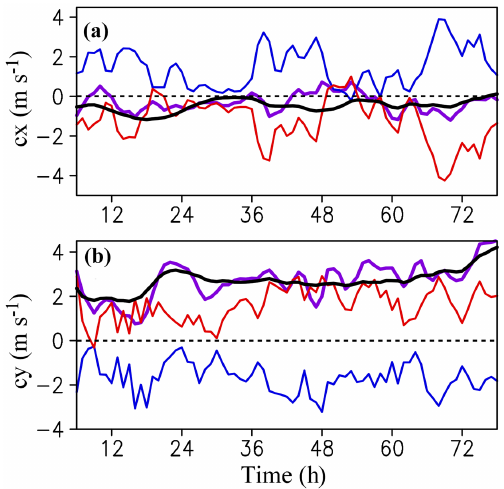
Figure 8. Time series of the conventional steering (thick black) and the contributions of the HA (thick purple), HA1 (red) and HA2 (blue) terms: (a) zonal component and (b) meridional component. Note that the conventional steering is deducted from the contribu- tion of the HA1